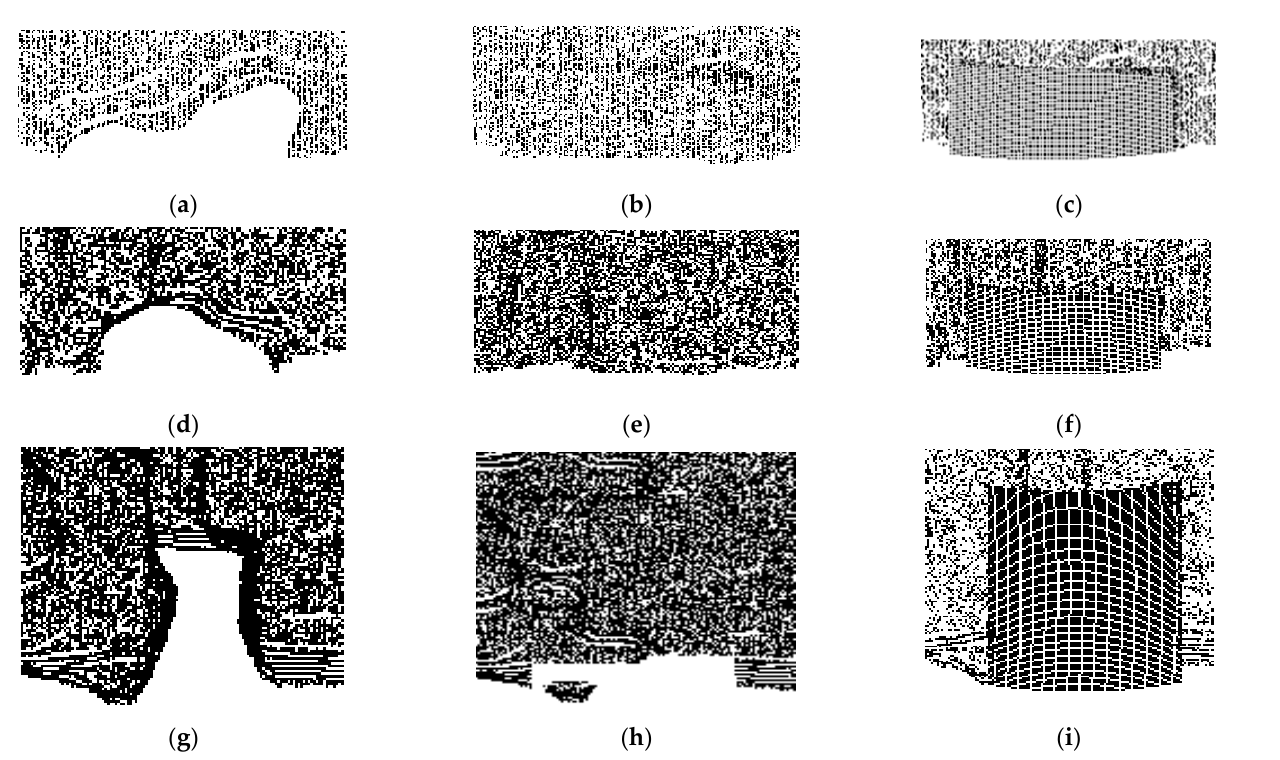
Figure 11. Repaired results using moving least square and the proposed method. ( a ) Hole 1 before filling, ( b ) Filling hole 1 by our method, ( c ) Filling hole 1 by MLS, ( d ) Hole 2 before filling, ( e ) Filling hole 2 by our method, ( f ) Filling hole 2 by MLS, ( g ) Hole 3 before filling, ( h ) Filling hole 3 by our method, ( i ) Filling hole 2 by MLS.